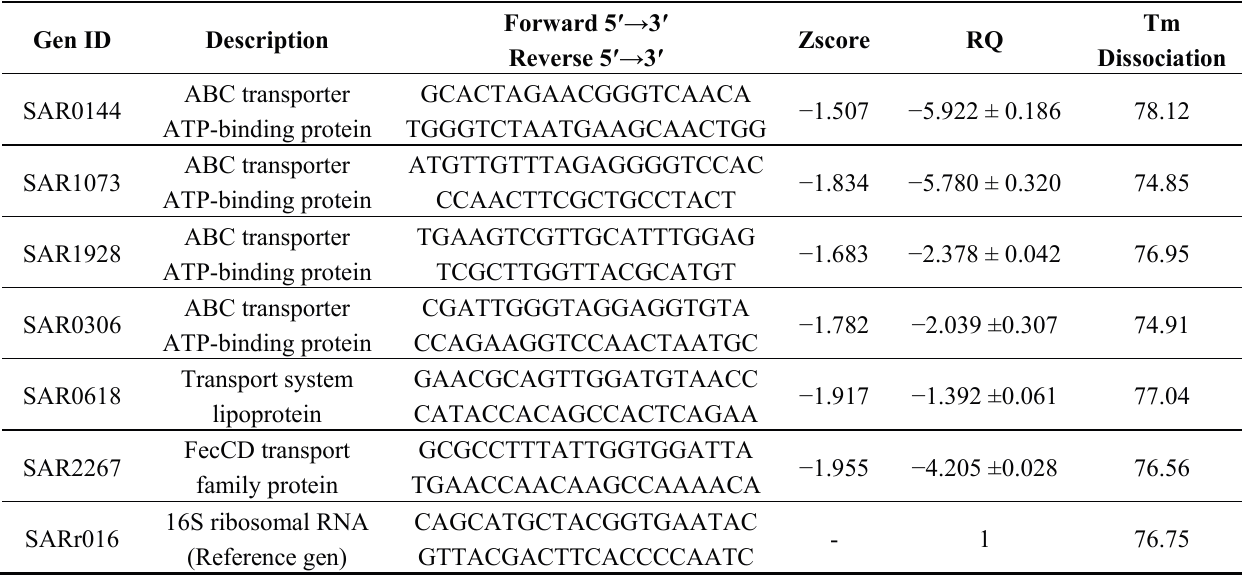
Table 2. Real-Time PCR of six repressed genes involved in ABC transport